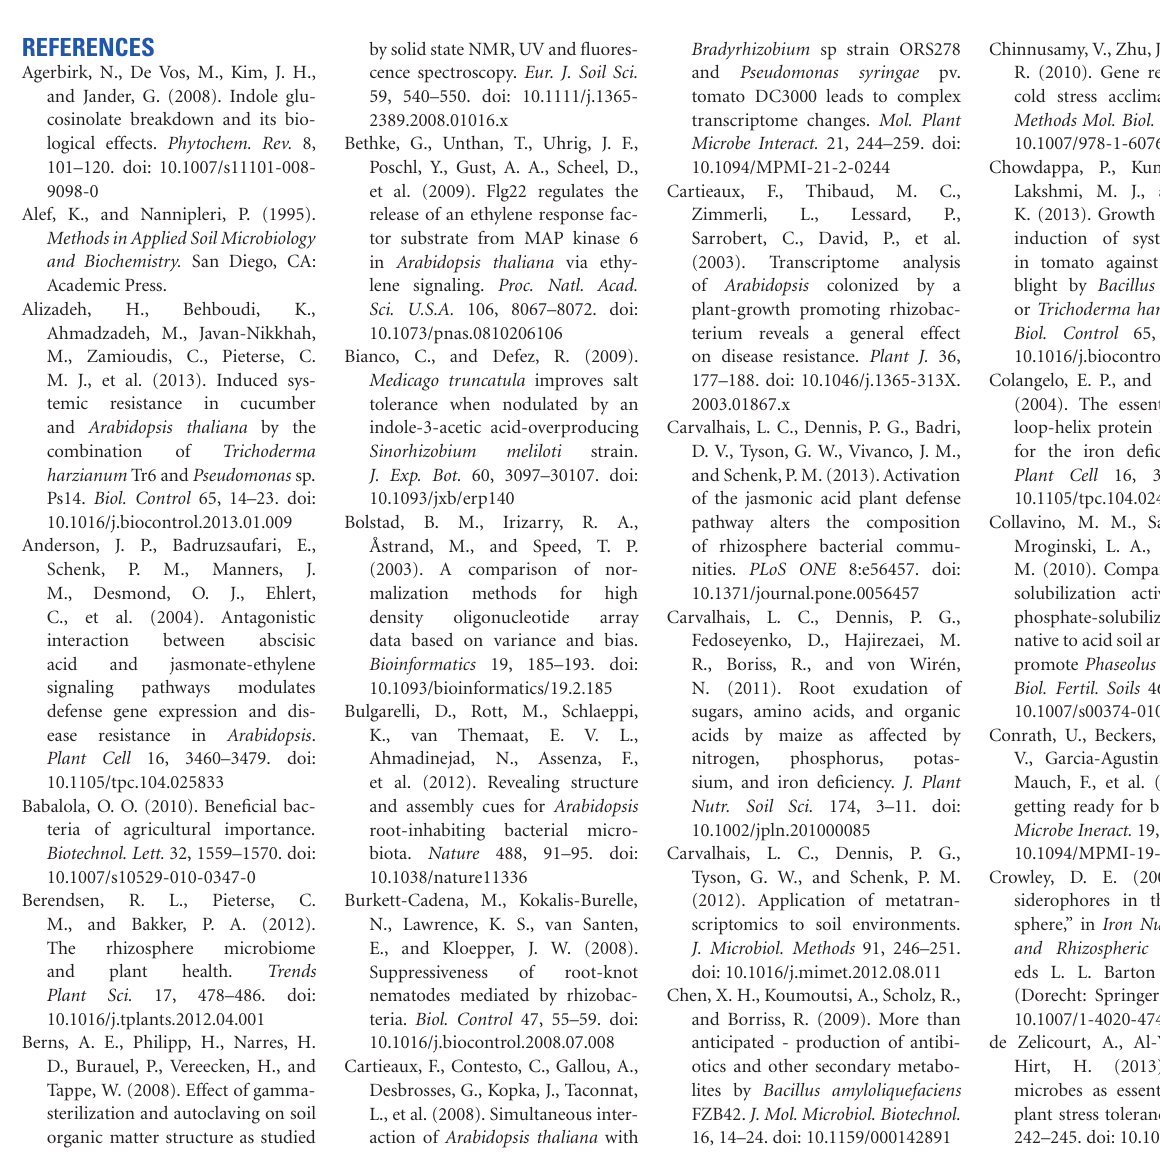
Table S1 | List of genes and primers used for qRT-PCR analyses. Table S2 | Genome-wide microarray data analysis of Arabidopsis plants grown in the absence or presence of whole soil microbial communities. The complete data sets are shown for root and shoot tissues, as well as lists of differentially expressed genes (up and downregulated in the presence of microbes) that passed all selection criteria for data analysis (see Materials and Methods for details). Table S3 | Identification of Gene Ontology (GO) functional categories that are enriched in transcript populations in roots in the presence of whole soil microbial communities. Figure S1 | Sampling of plant shoots, roots and rhizosphere soil. First, plants were carefully uprooted, soil attached to roots (rhizosphere soil) was shaken off and sieved. Plants were then carefully washed to remove excess soil and briefly blotted onto tissue paper. Shoots and roots were sampled separately. All samples were immediately snap-frozen in liquid